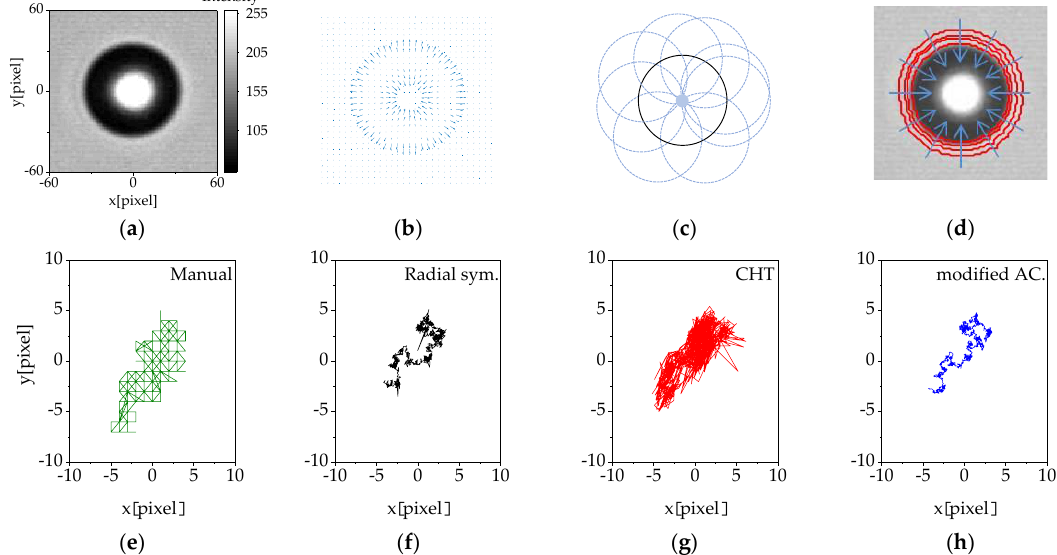
Figure 3. ( a ) The intensity distribution of a cPMS image. ( b – d ) The illustration of the 3 different localization methods; ( b ) radial symmetry, ( c ) circular Hough transformation and ( d ) modified active contour method. ( e – h ) The representative trajectory of MCF-7 cell using different localization method; ( e ) manual localization, ( f ) radial symmetry, ( g ) circular Hough transformation and ( h ) modified active contour method.